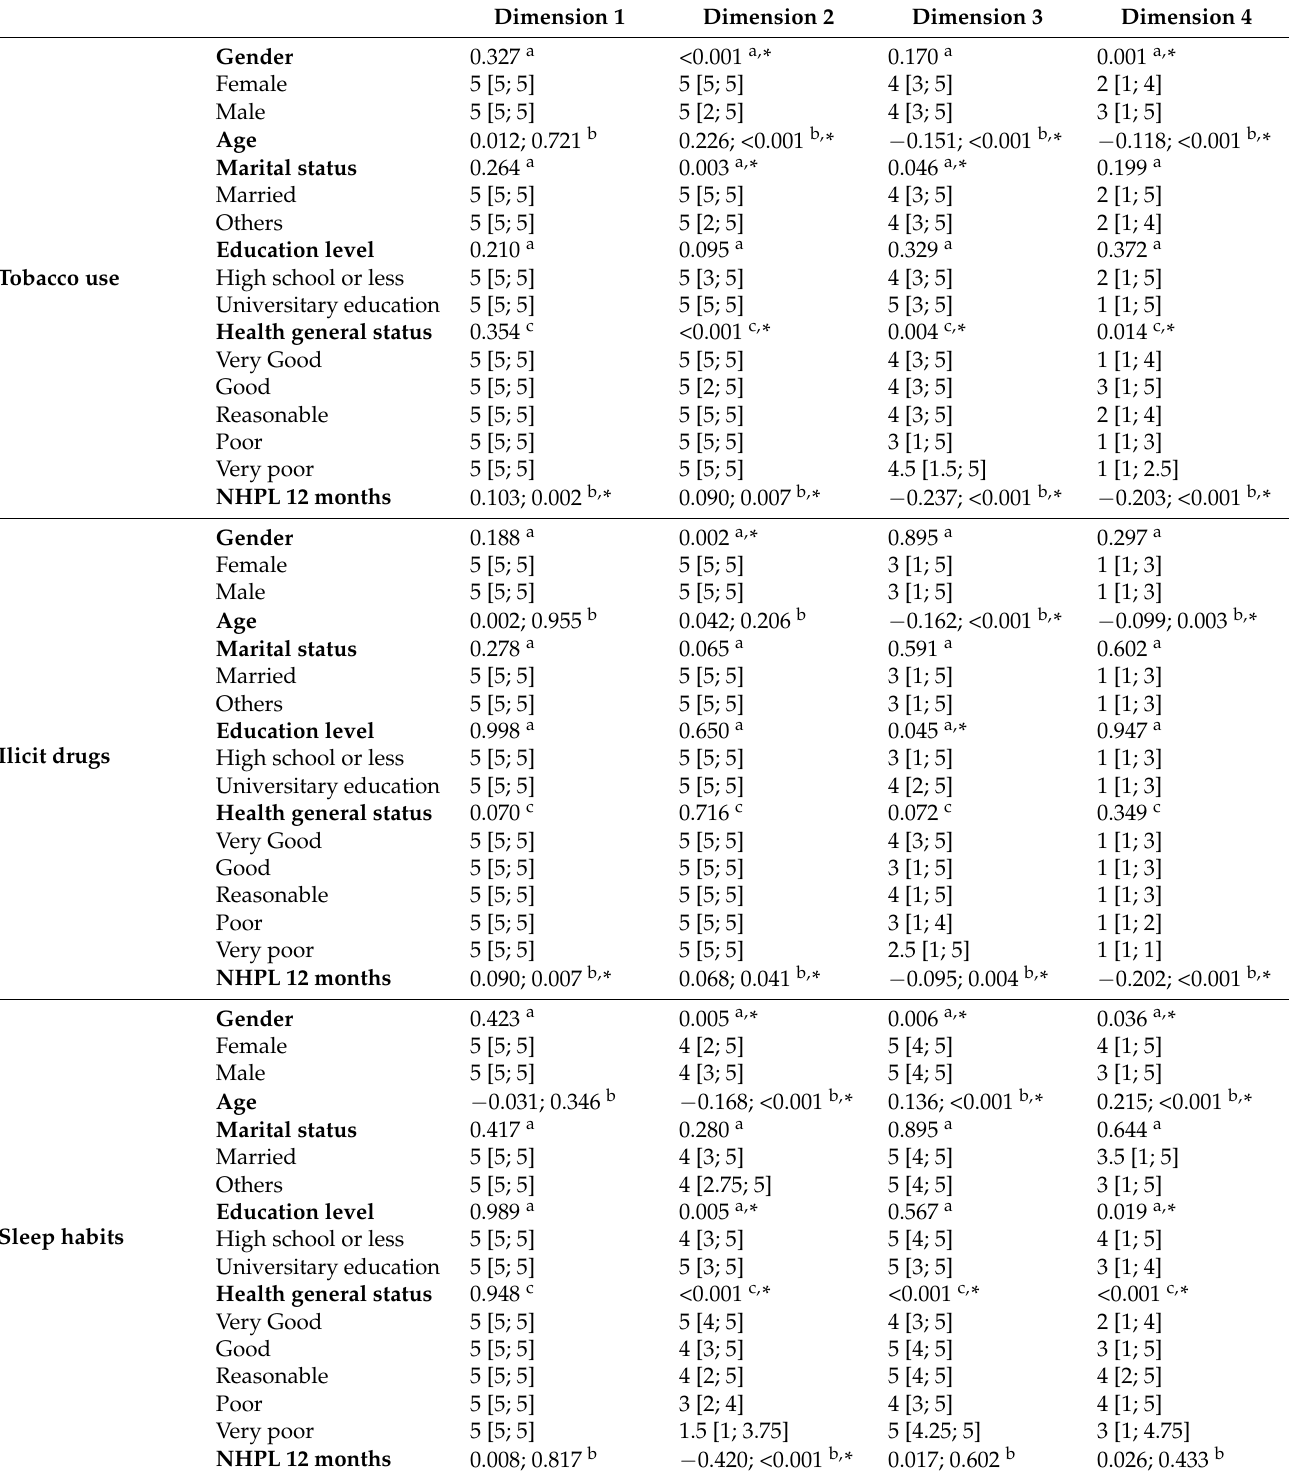
Table 5. Cont . Dimension 1 Dimension